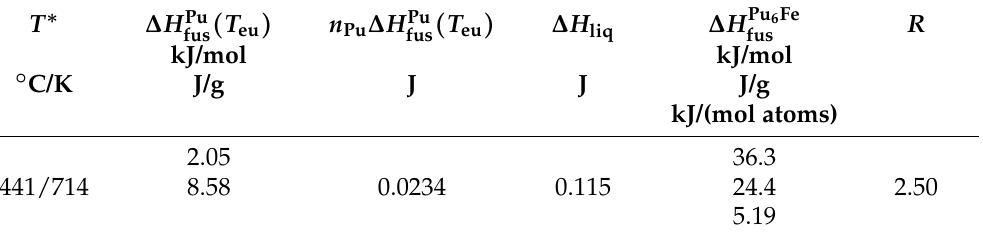
Table 5. Reanalysis of the STR data [3] based on Equation (2), using the phase diagram of Reference [7]. T ∗ is the liquidus temperature at an a/o Fe of 13.1, and R is defined in Equation (17) of the